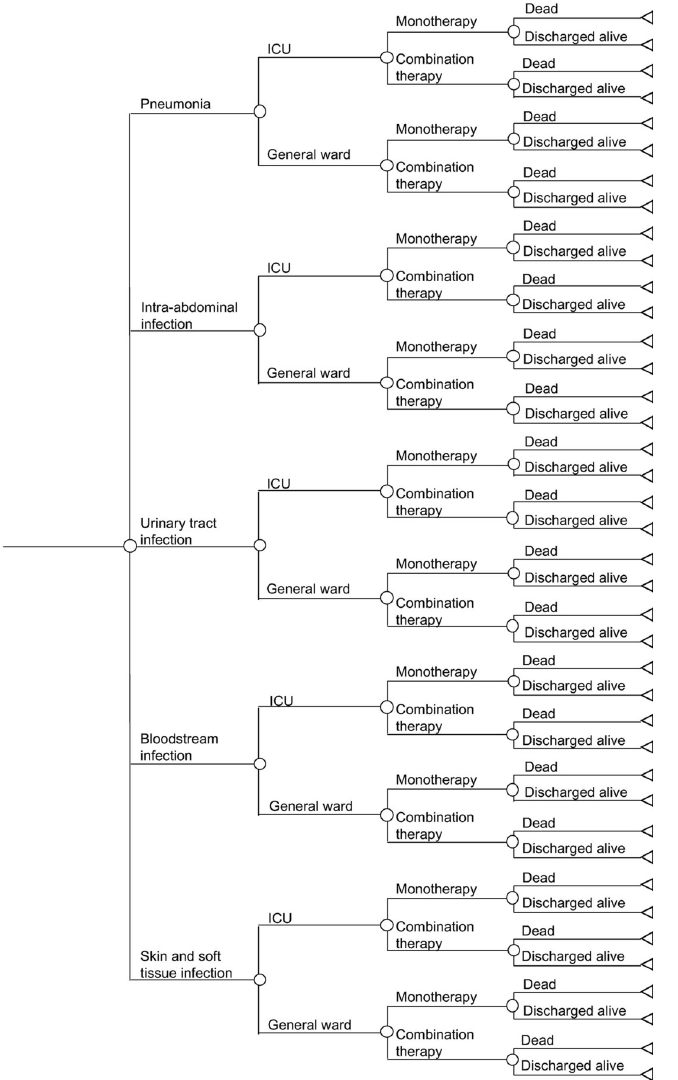
Fig 1. Tree diagram for carbapenem-resistant Enterobacterales